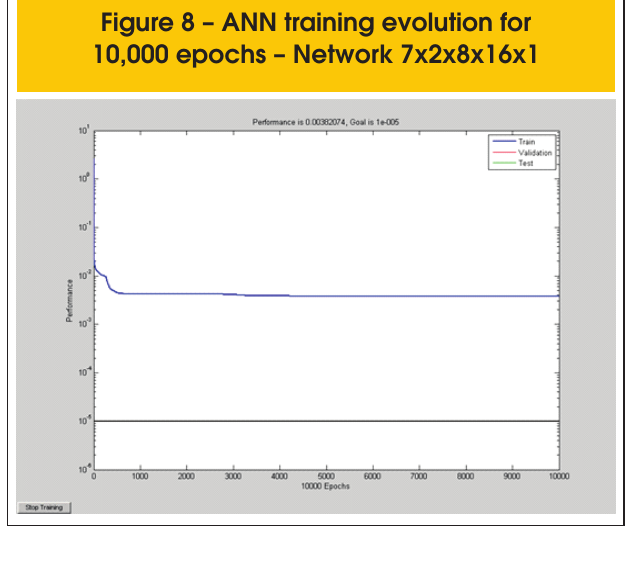
Figure 12 – Estimate mean error – Networks st 8 neurons in the 1 hidden layer